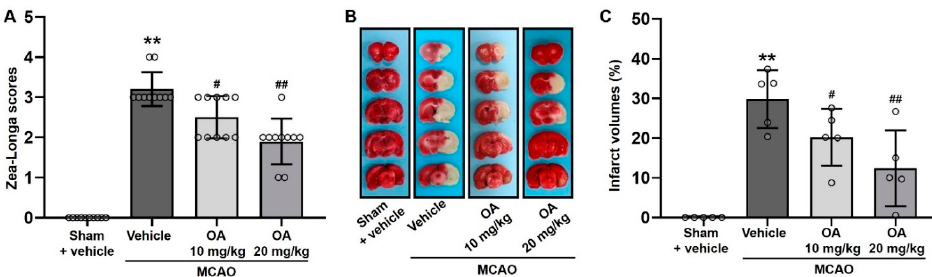
Figure 2. OA administration attenuated neurological deficits and cerebral infarction in MCAO rats. ( A ) Quantitative analysis of neurological function monitored using Zea-Longa scoring. ( B ) Representative images and ( C ) quantitative analysis of infarct volume in the brain (pale area) monitored by TTC staining. Data are shown as the mean ± S.D. ** p < 0.01 versus the sham + vehicle group; # p < 0.05 and ## p < 0.01 versus the MCAO + vehicle group.